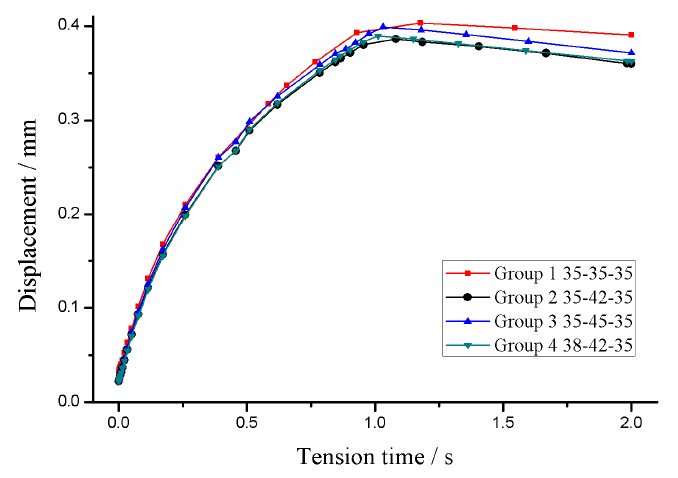
Figure 10. Deformation magnitude of the interface in the vicinity of Rivet 3# on inner sheet.